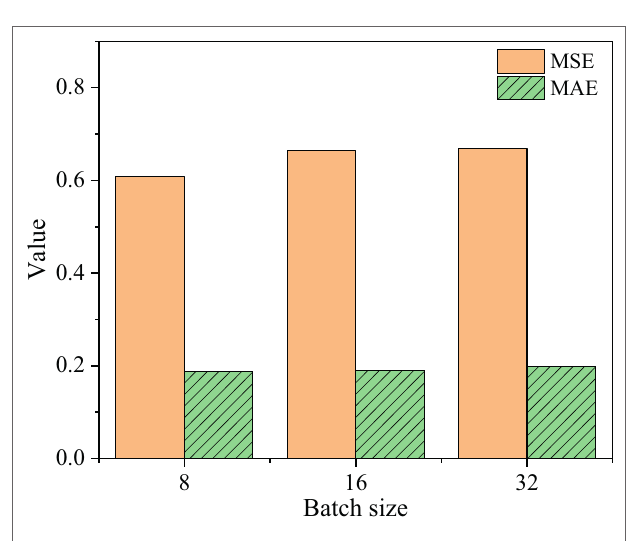
FIGURE 9 | When the learning rate is 1e-4, the corresponding MSE and MAE